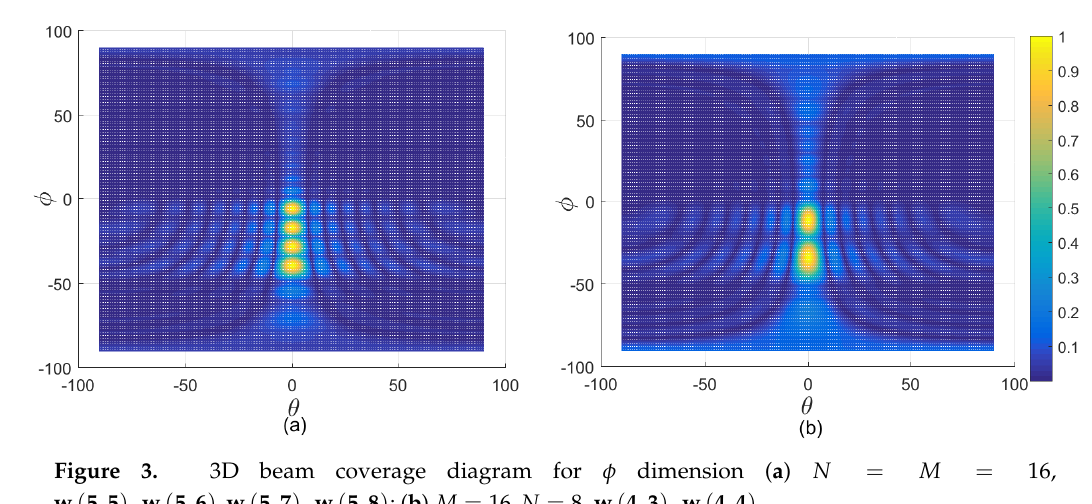
Figure 3. 3D beam coverage diagram for φ dimension ( a ) N = M = 16, w ( 5 , 5 ) , w ( 5 , 6 ) , w ( 5 , 7 ) , w ( 5 , 8 ) ; ( b ) M = 16, N = 8, w ( 4 , 3 ) , w ( 4 , 4 )